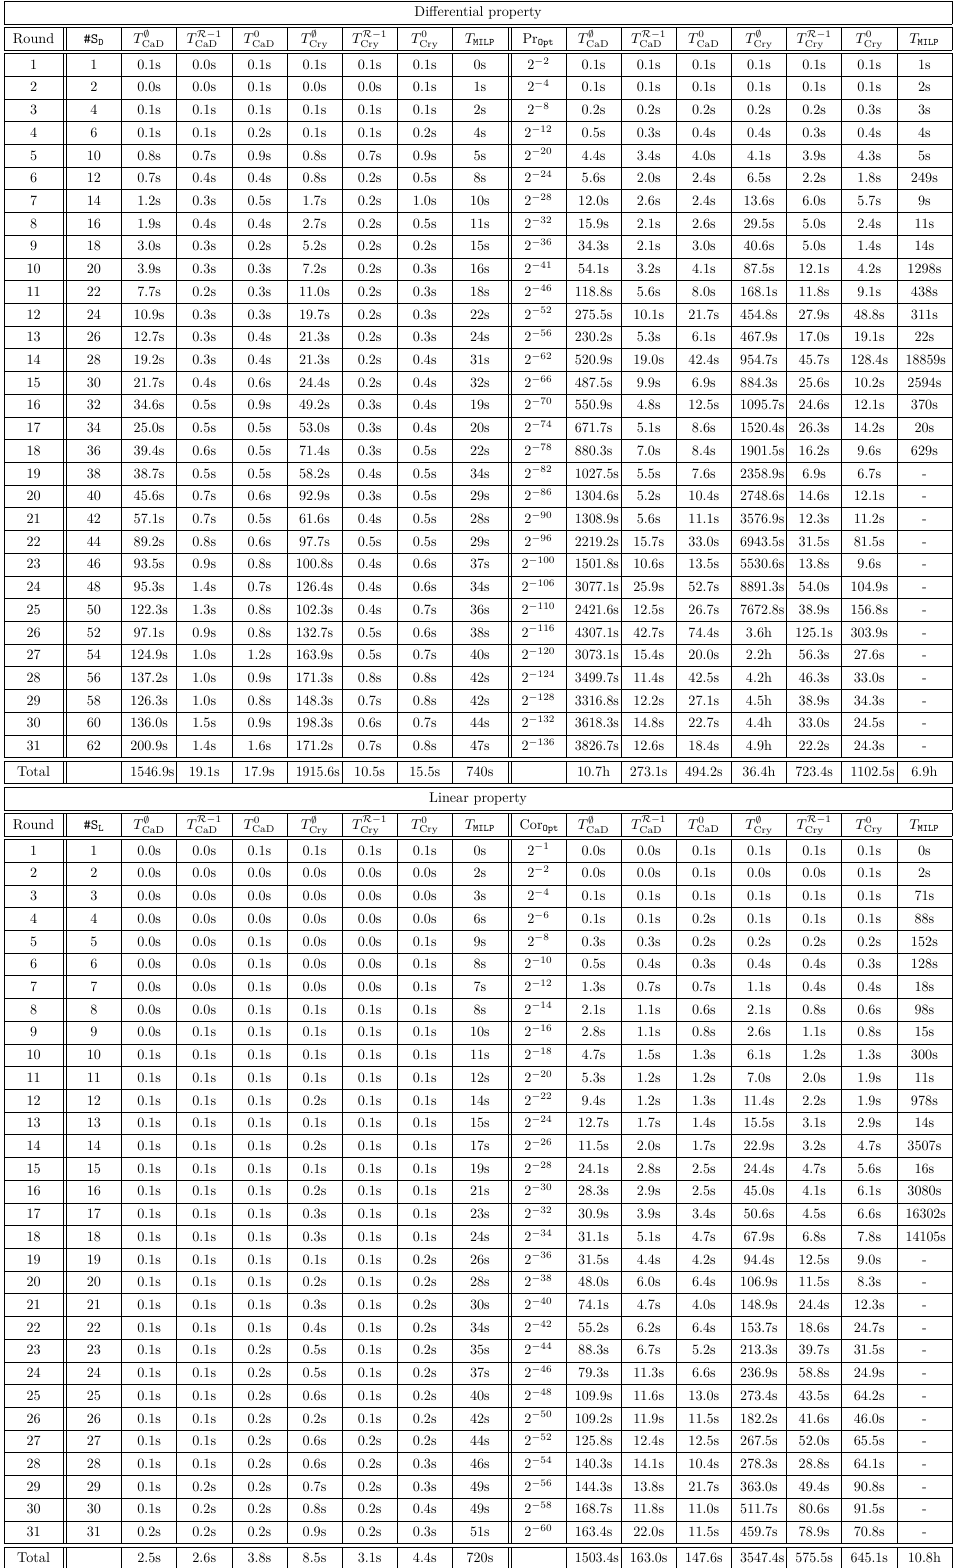
Table 12: Experimental results of PRESENT